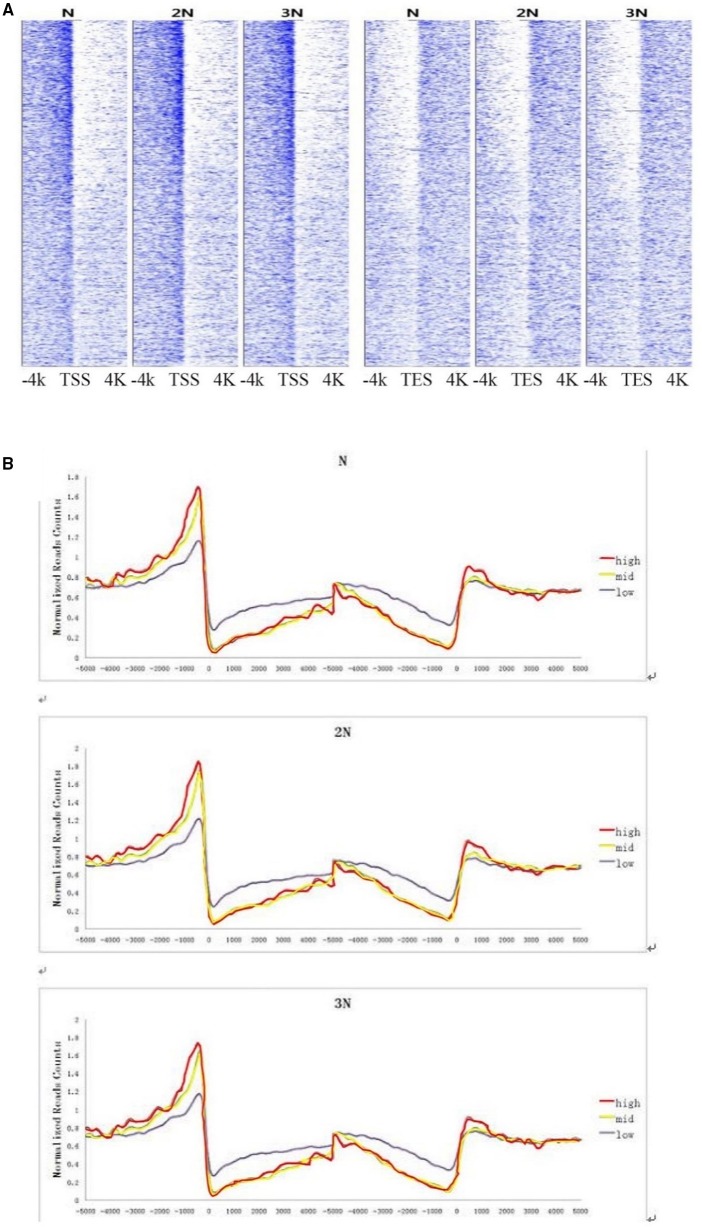
(A) Correlation between DNA methylation and gene expression levels at sites 4 kb upstream and downstream of the TSS and TES at the genome-wide level. The X-axis shows the location 4 kb upstream and downstream of the TSS and TES. The Y-axis shows gene expression levels. Each dot represents one DNA methylation read. (B) DNA methylation levels of highly expressed, moderately expressed and weakly expressed gene populations. Highly expressed genes: read counts >200; moderately expressed genes: read counts 30–200 (Wendel); weakly expressed genes: read counts <30.